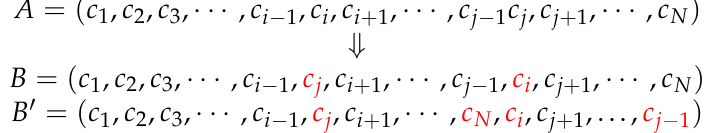
Figure 1. Permutation operator operation. (2) Shift Operator.